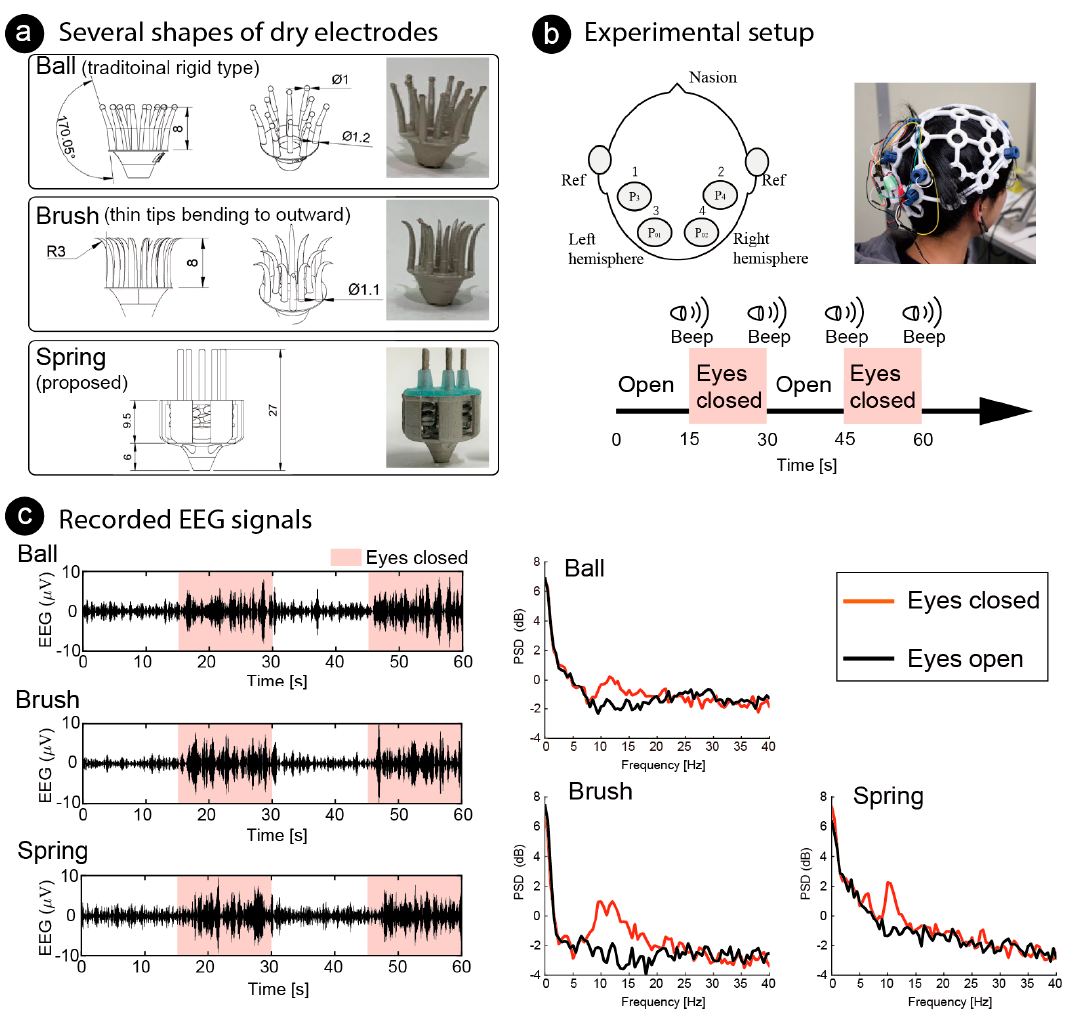
Figure 10. Functional testing of several shapes of dry electrodes. ( a ) Ball electrode, common shape of dry electrodes, with eleven prongs; brush electrode, designed for the bristles to bend by bending outward with pressing force, also with eleven prongs; fabricated electrode with five coiled-spring prongs. ( b ) For functional test of electrodes, electroencephalography (EEG) was measured while the participant closed / opened his eyes. Amplitudes of alpha wave (8–12 Hz) increased while eyes were closed. Dry electrodes were placed at four positions covering visual cortex and reference electrodes were placed on the earlobes. ( c ) Recorded EEG signals at P3 of PID1 are illustrated on left. Butterworth 1st-order filter (8–12 Hz) was used to emphasize alpha band. Light pink areas indicate the time the eyes remained closed, and other areas indicate the time the eyes remained open. Median of power spectrum densities (PSD) are shown on the right. Red lines show PSDs while the eyes were closed, and black lines show that while the eyes were open.